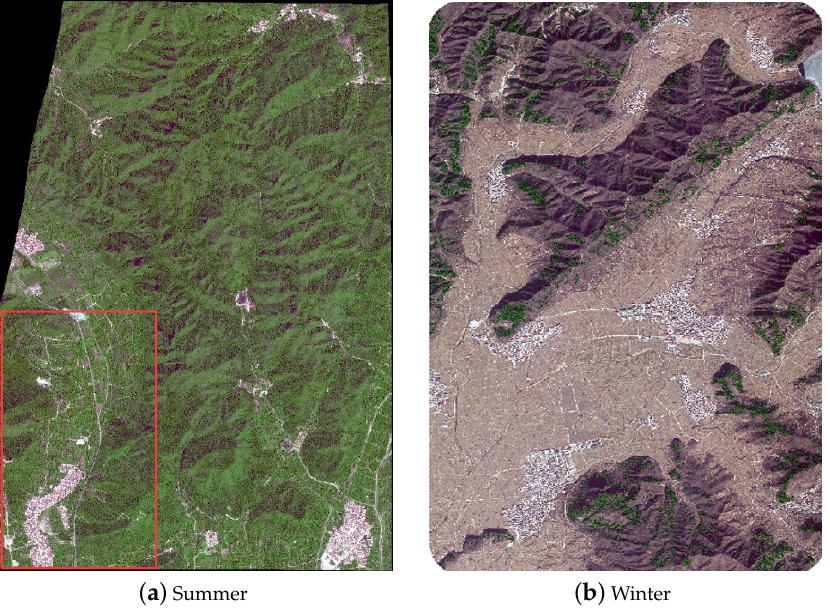
Figure 9. These are the two images of SV-1. The left image is 10,803 × 13,786 and shows the main area around Yaji Mountain, where the red box marks the test area, and the other indicates the training area; the right 10,673 × 20,220 image is located east of the left image and is a winter image used as a supplement to the training